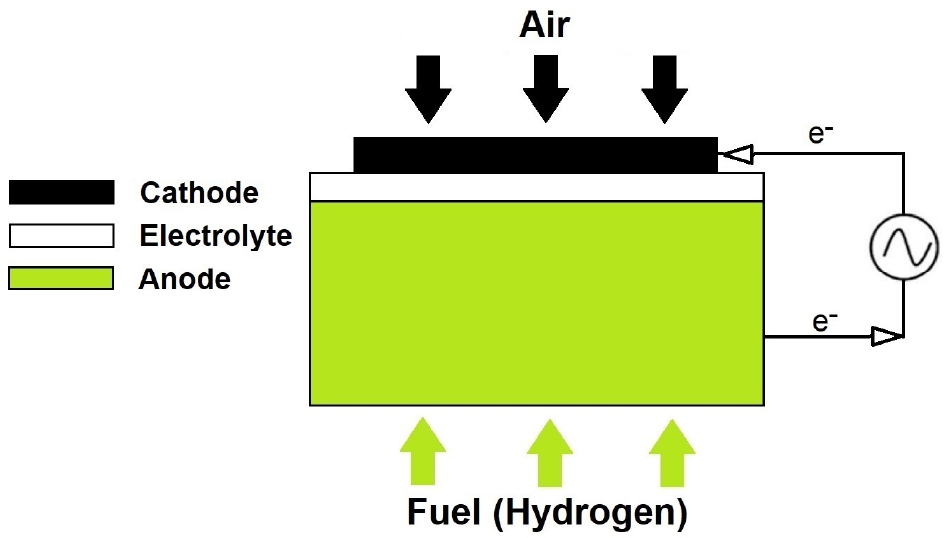
Figure 1. General scheme of a solid oxide fuel cell.